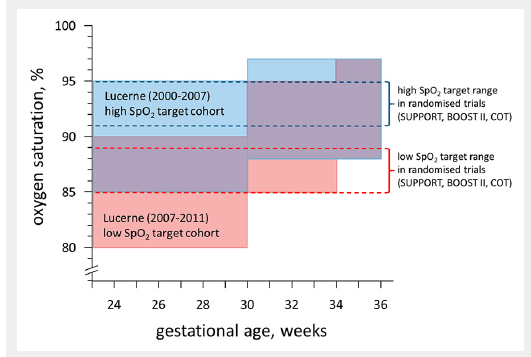
Oxygen saturation (SpO 2 ) target policies at the Children’s Hospital of Lucerne: (A) between 1 January 2000 and 30 June 2007, SpO 2 targets were 85 to 95% at <30 weeks and 88 to 97% at ≥30 weeks (high SpO 2 target cohort); (B) between 1 July 2007 and 31 December 2011, SpO 2 targets were lowered to 80 to 90% at <30 weeks, 85 to 95% between 30 and 34 weeks and finally 88 to 97% at ≥34 weeks (low SpO 2 target